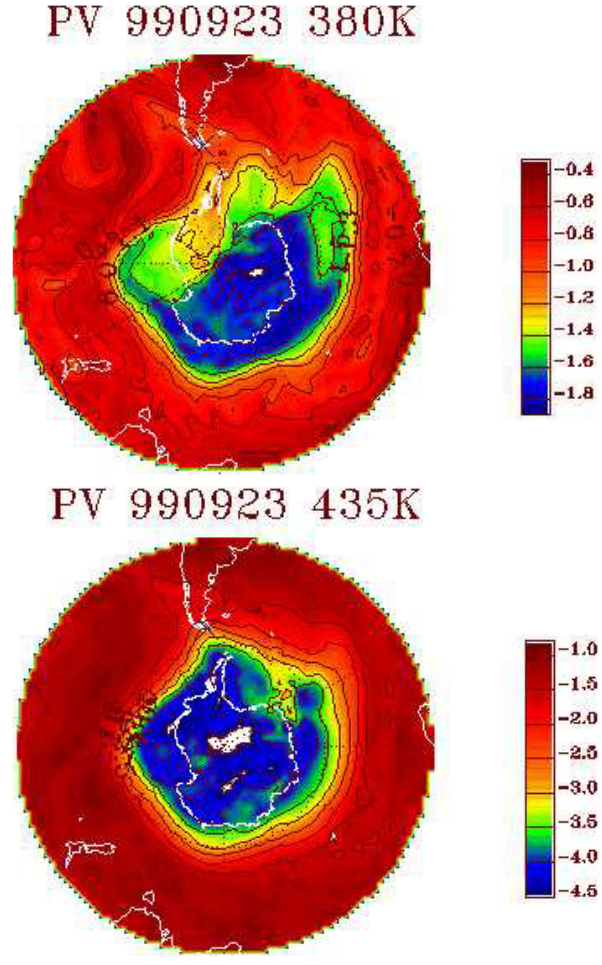
Fig. 4. Potential vorticity for 23 September 1999, diagnosed from ECMWF analyses, for the 380 K and 435 K isentropic